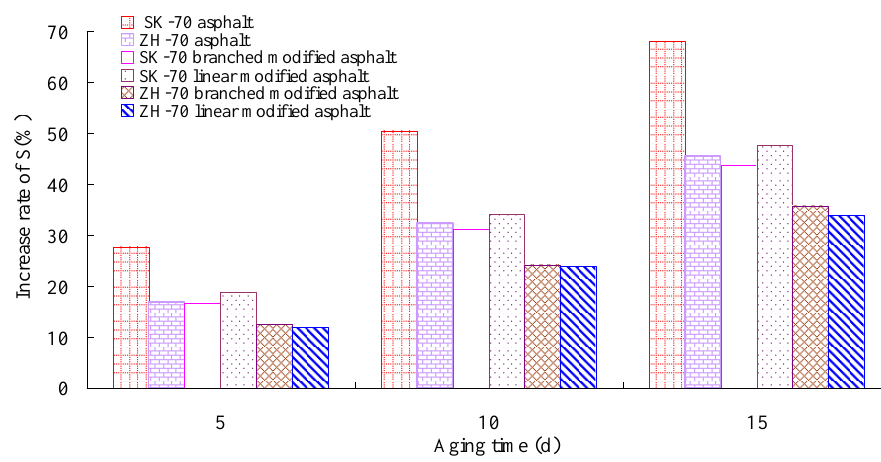
Figure 11. Increase rate of stiffness modulus and aging time.